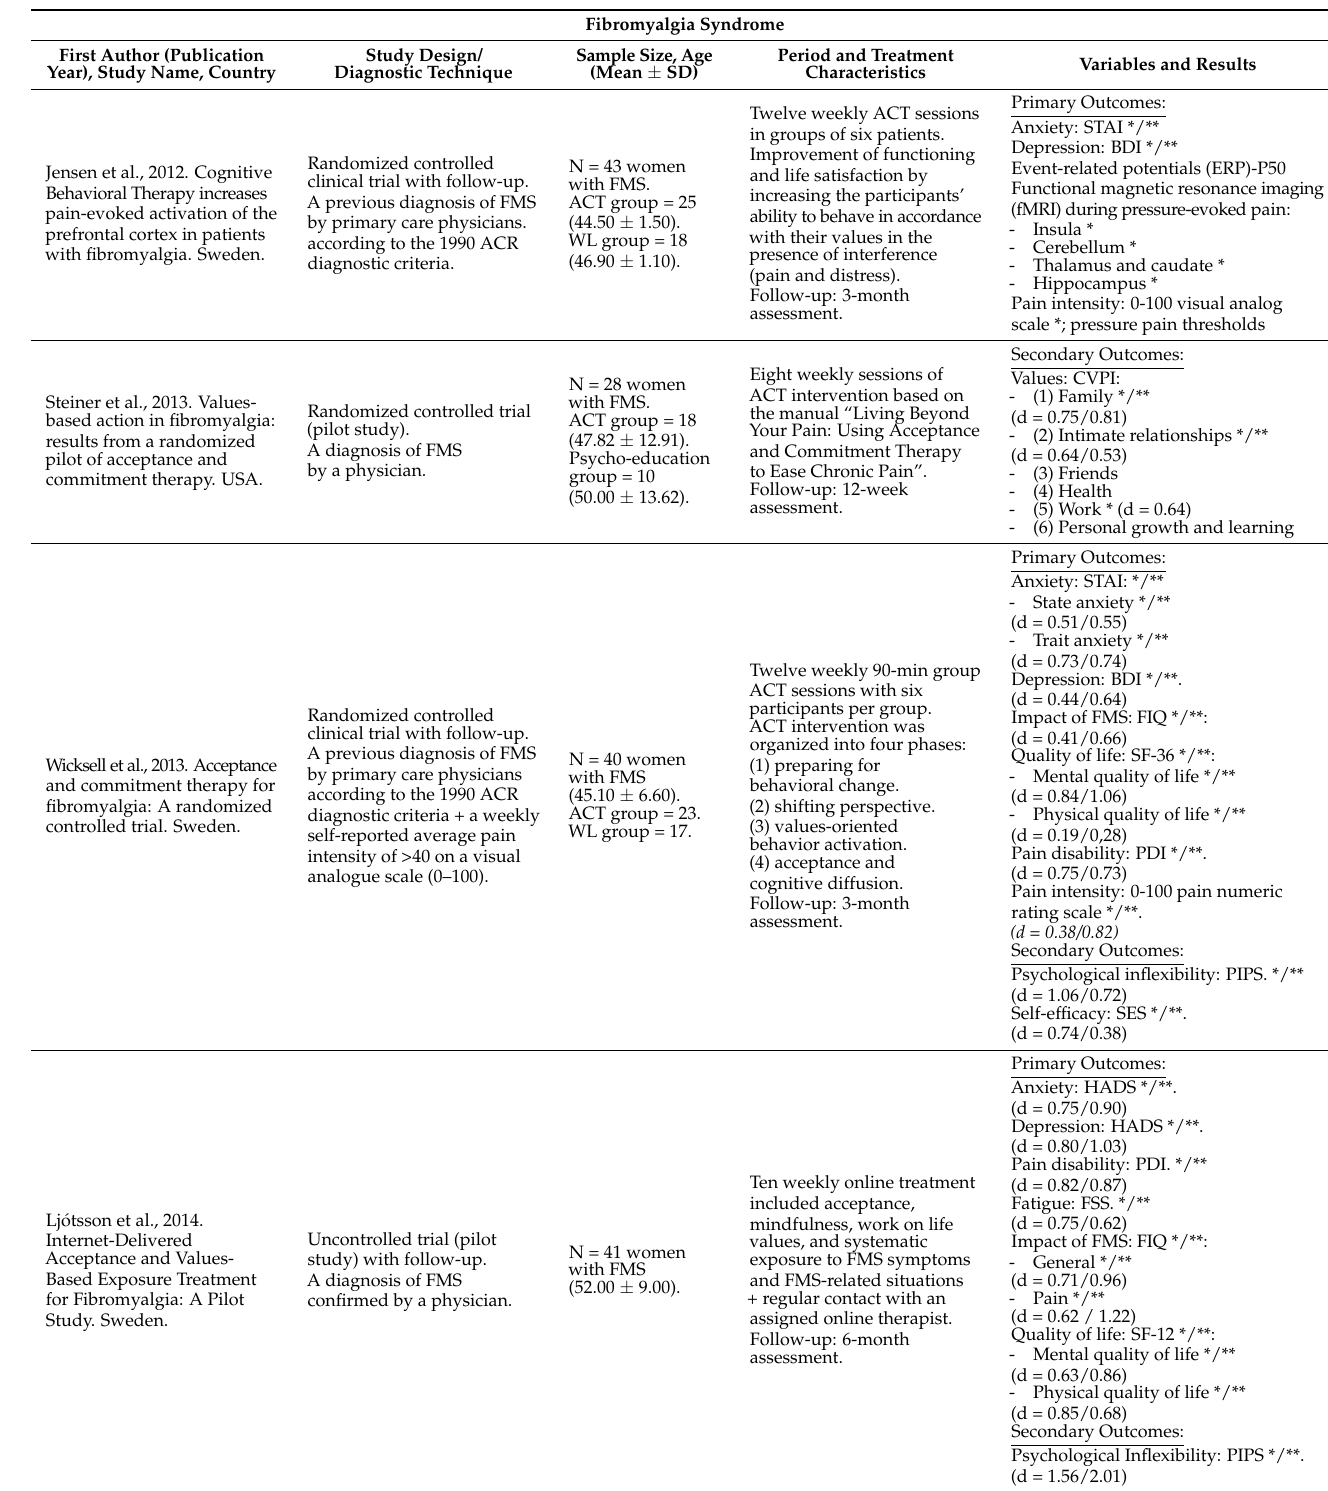
Table 1. Characteristics of selected studies on the effectiveness of acceptance and commitment therapy for central pain sensitization